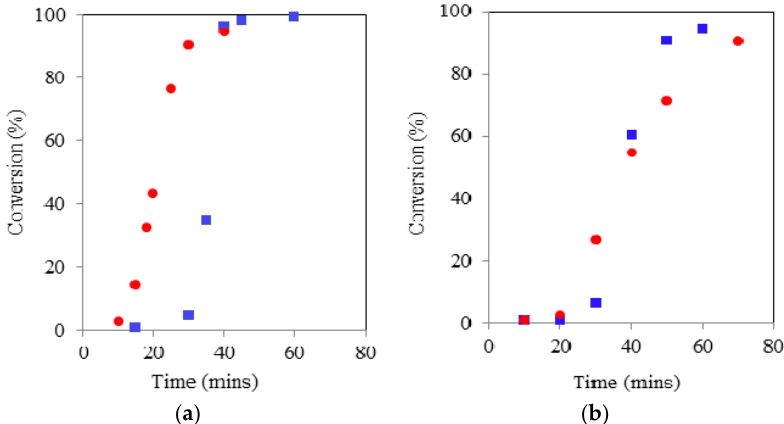
Figure 4. Comparison of G ( a ) and Glycerol Ethoxylate (GE) ( b ) initiated ROP the kinetics using CH ( ■ ) and MWH ( ) (150 °C, DP90). Figure 2. Comparison of TMP initiated ROP kinetics using CH ( ) & MWH ( ) at 150 °C and target DP 90 ( left ) and 21 ( right